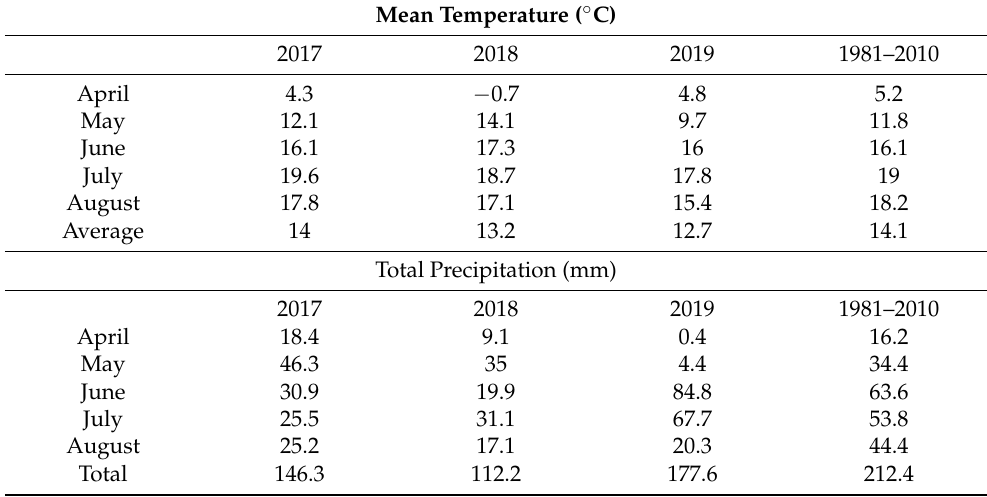
Table 3. Mean temperature and total precipitation at the experiment site.